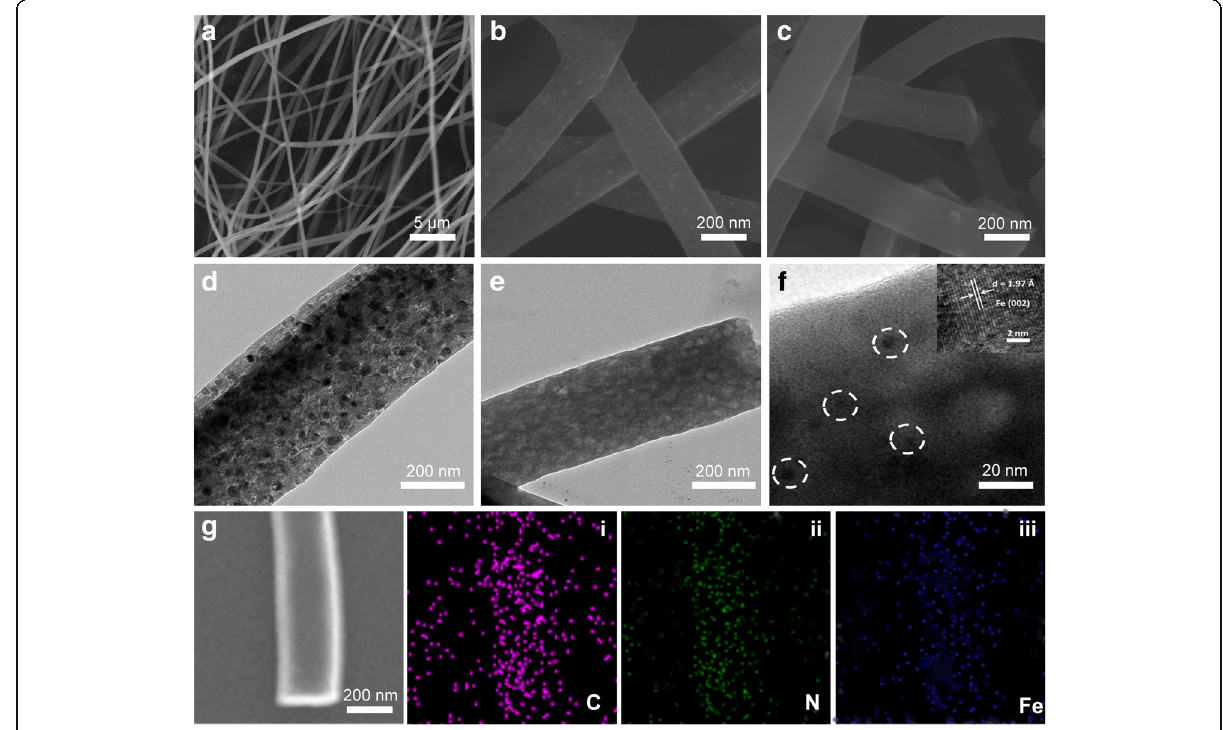
Fig. 2 SEM images of FN-800: before calcination ( a ), calcination in 800 °C ( b ), and with acid immerse ( c ). TEM images of FN-800: calcination in 800 °C ( d ); with acid immerse ( e , f ). The inset of f is HERTEM of the white circle area. SEM and corresponding element mapping image of FN-800 ( g SEM; i C; ii N; iii